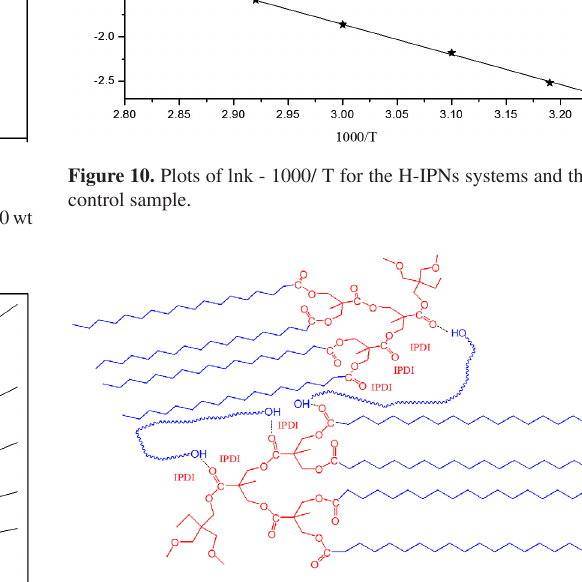
Figure 11. The compatibility between SHPE, HTPB and IPDI (In which stand for main chain of